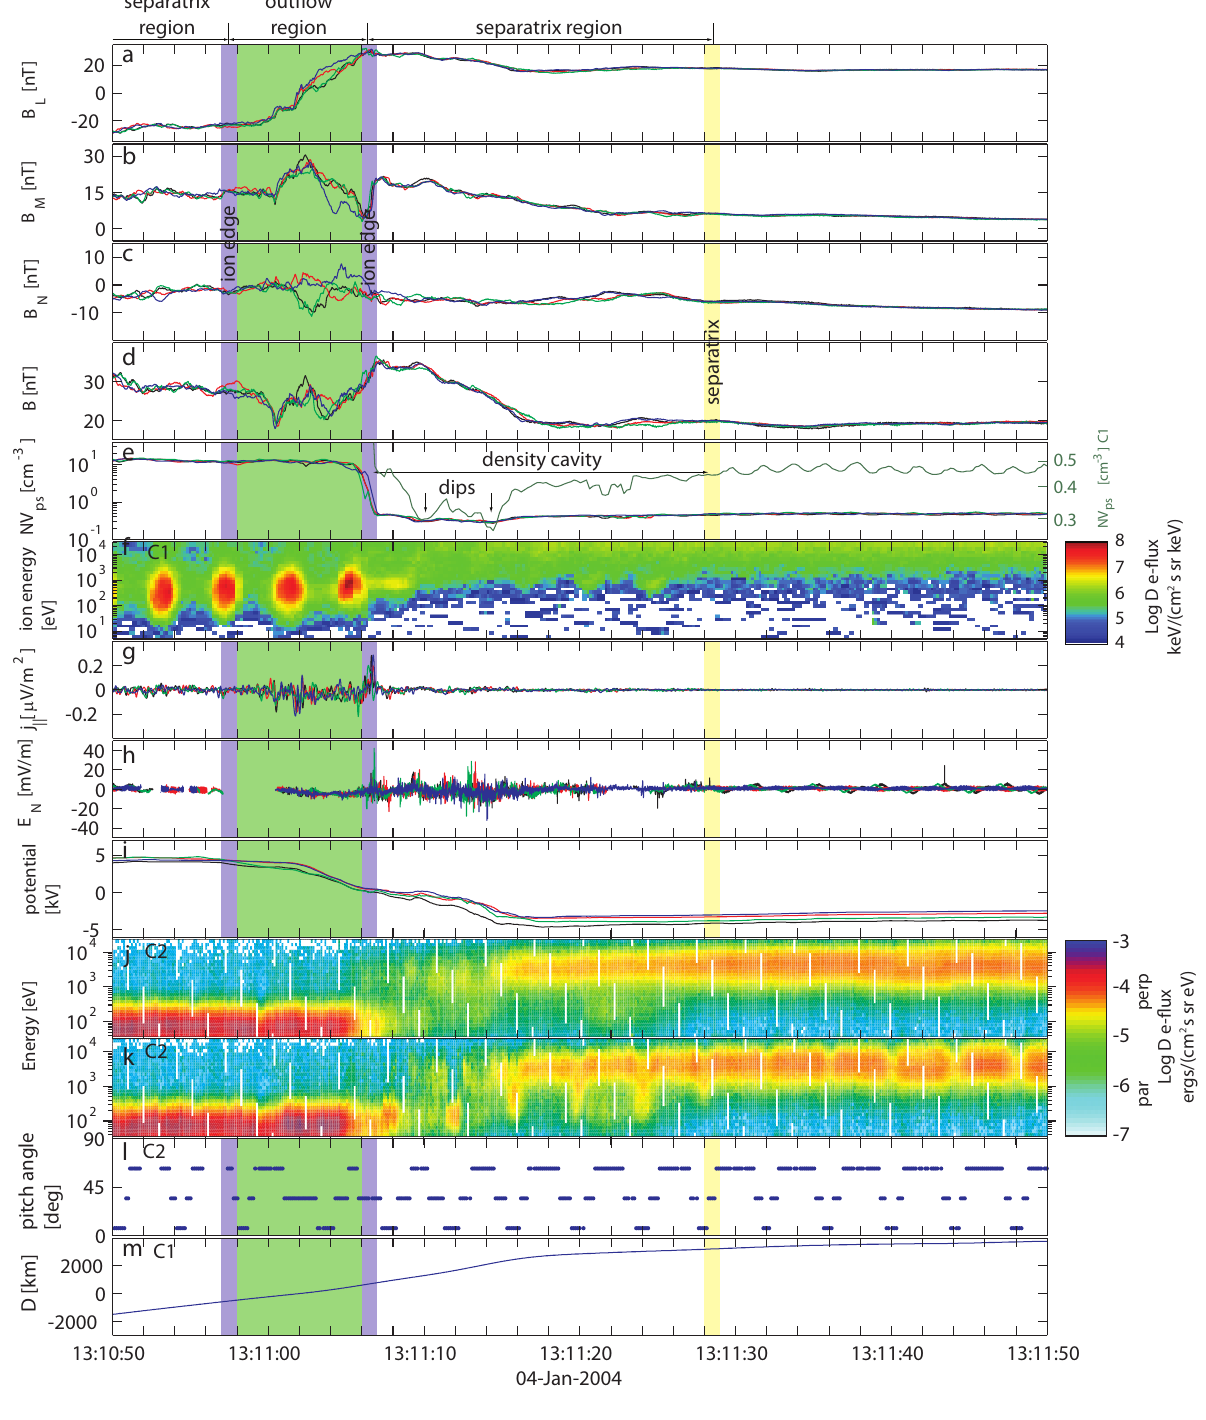
Fig. 8. Cluster crossing of the magnetopause reconnection layer on 4 January 2004, 13:11UT. Panels (a–d) show the magnetic field LMN - components and magnitude of the magnetic field for all four spacecraft. Panel (e) shows the density and the density on a different scale from C1, (f) the energy spectrogram of ions over all angles from C1, (g) the current density parallel to the magnetic field, (h) the normal electric field, (i) the electric potential, (j) the energy spectrogram of electrons perpendicular to the magnetic field from C2, (k) the energy spectrogram of electrons with the smallest measured pitch angle, from C2 and (l) the pitch angle of electrons in panel (k) , (m) the distance to the magnetopause. The black, red, green and blue lines represent spacecraft 1, 2, 3 and 4, respectively. The LMN -directions are the same as in Fig. 7. The time axes for spacecraft 1–4 are shifted by [1.0 0 0.5 −